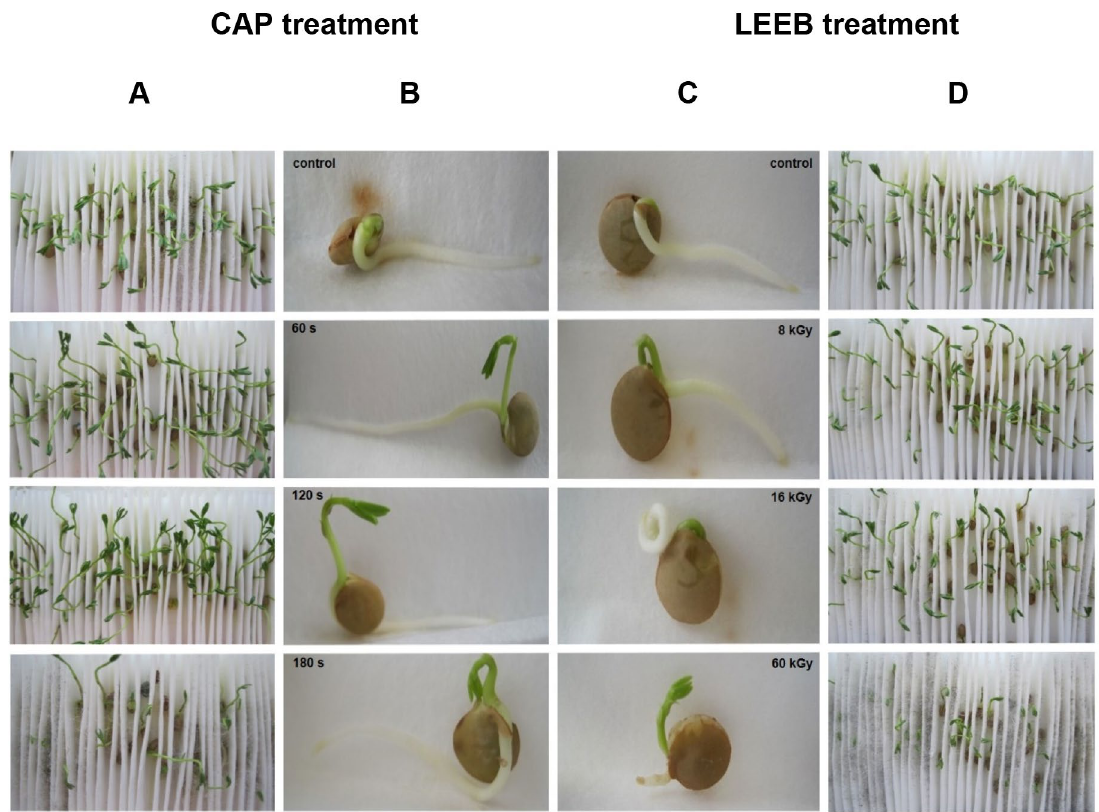
Figure 2. Morphology of seedlings resulting from CAP and LEEB treated lentil seeds. Qualitative assessment of 7-day-old ( A ) and 4-day-old ( B ) untreated and CAP treated lentil seeds with increasing CAP exposure time. Qualitative assessment of 4-day-old ( C ) and 7-day-old ( D ) untreated and LEEB treated seeds. Root abnormalities were observed for 8 kGy treatment and higher doses. Curling and shortening of roots was visible in seeds starting from 16 kGy